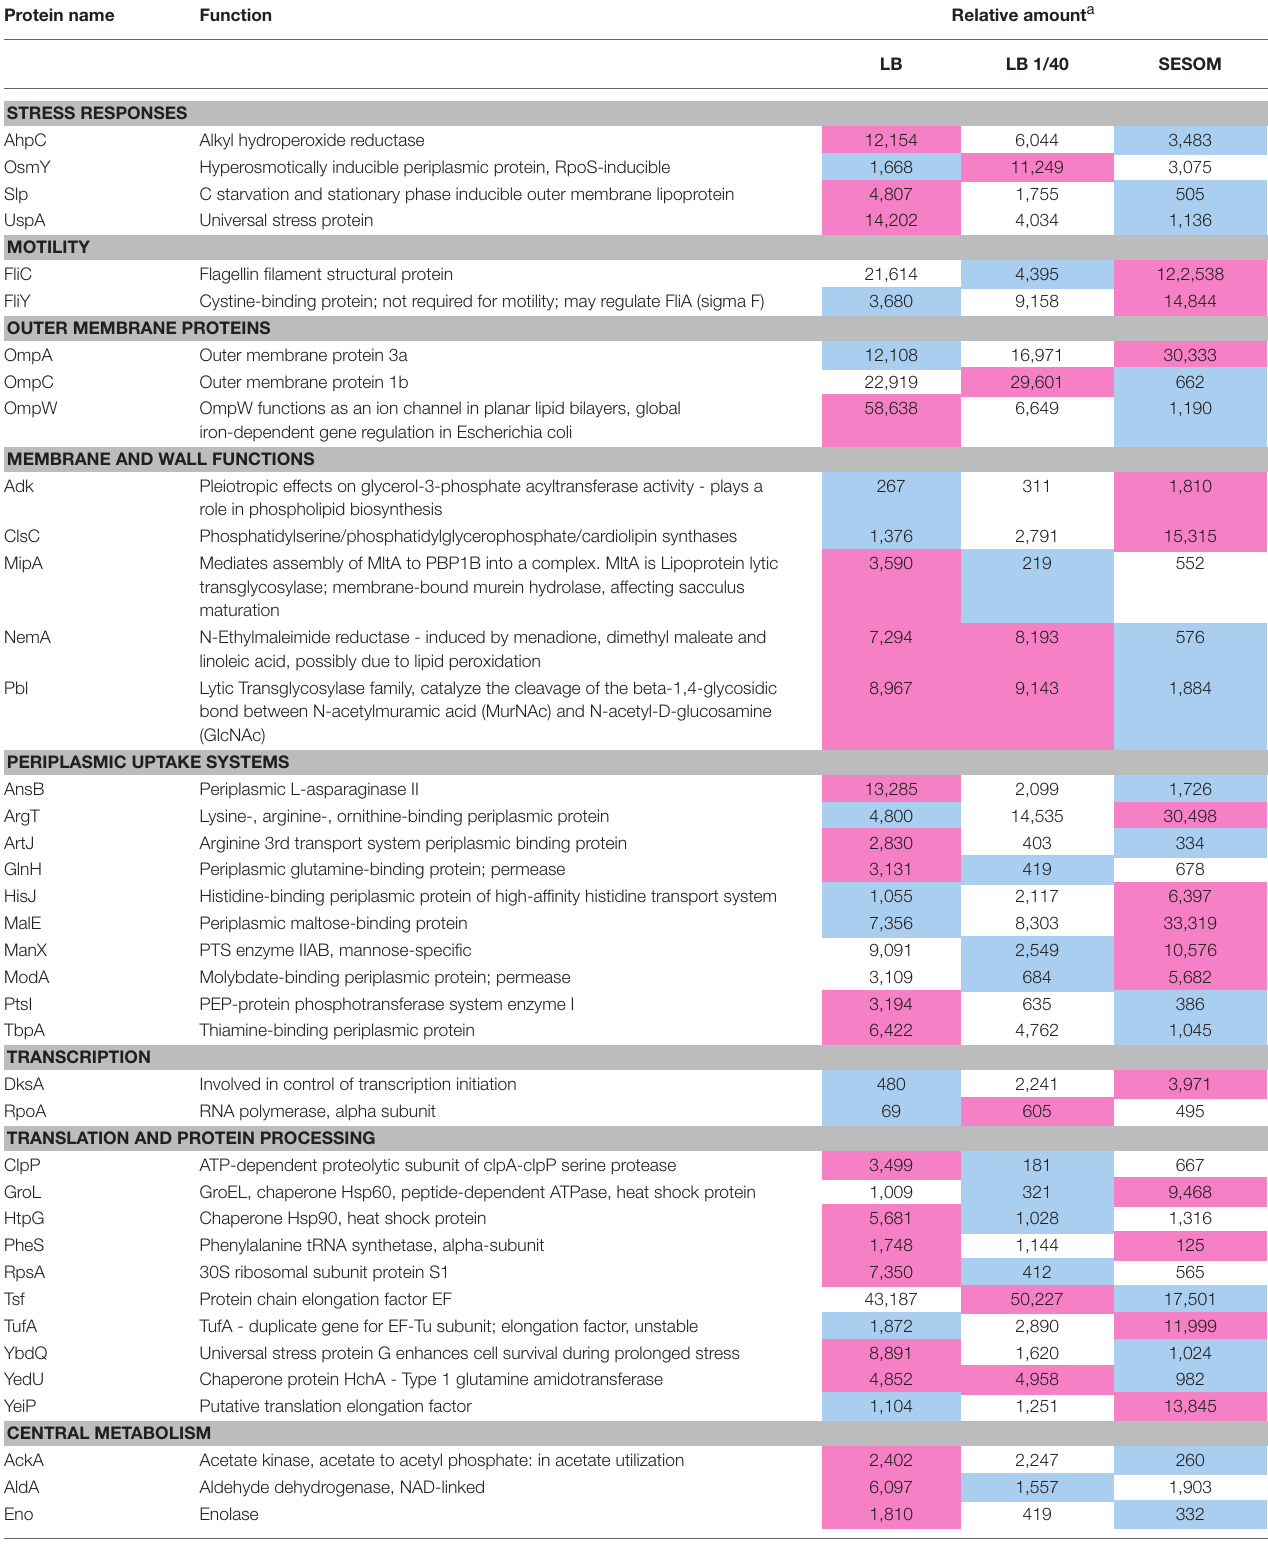
TABLE 1 | Proteins of different abundance in stationary phase (3d) populations of E. coli O157:H7 grown and maintained in LB, 1/40-strength LB and SESOM at 30 ◦ C. Protein